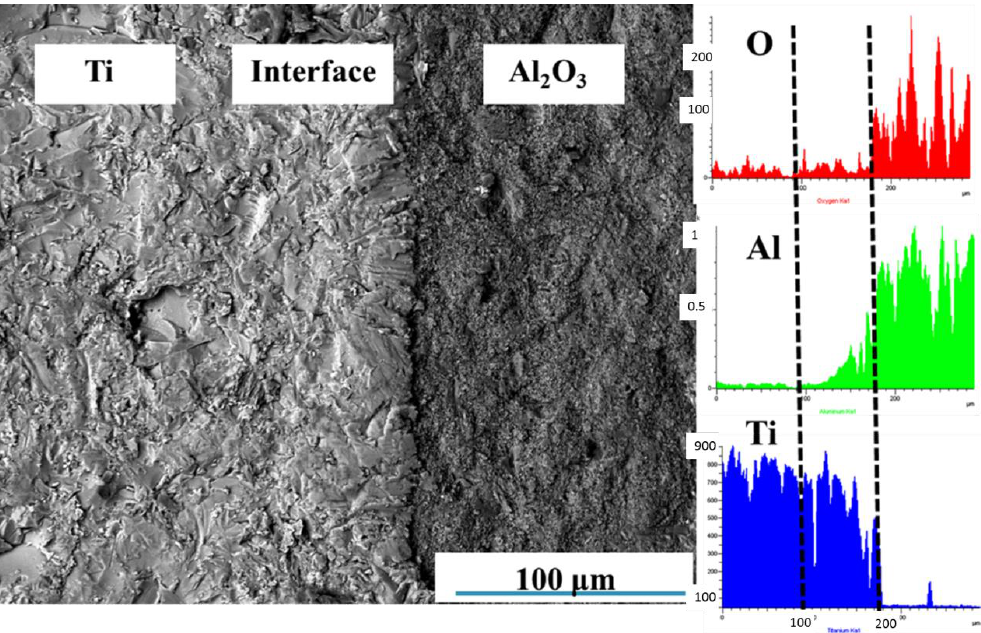
Figure 3. SEM images and line scanning analysis of the interface at 1350 ◦ C holding for 1.5 h.